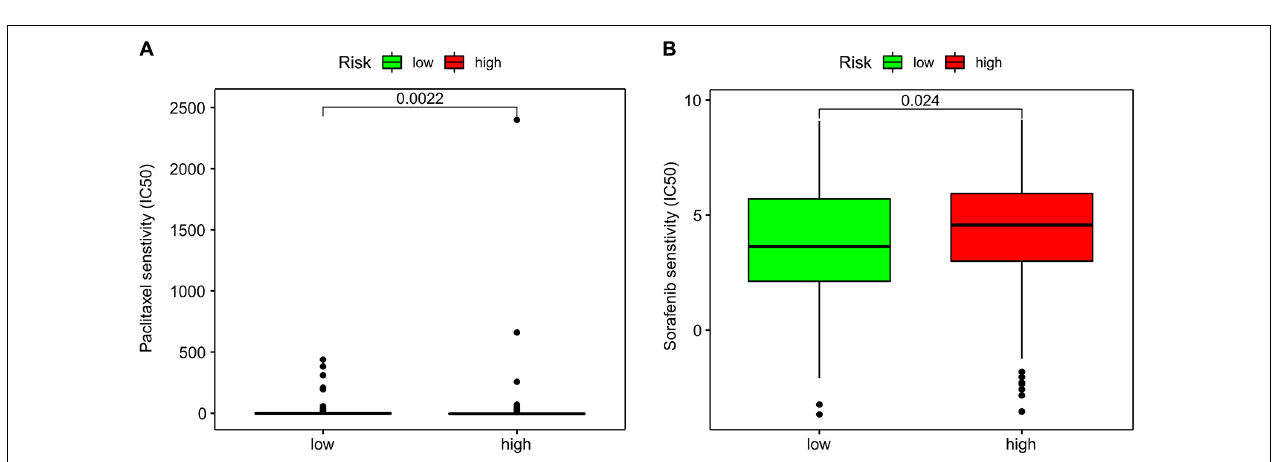
FIGURE 6 | Association of the ImmiRSig with immune microenvironment. (A) The relationship between each immune cell and the ImmiRSig. (B) The infiltration levels of T cell CD4 + , macrophages, and myeloid dendritic cells in the high- and low-risk group.